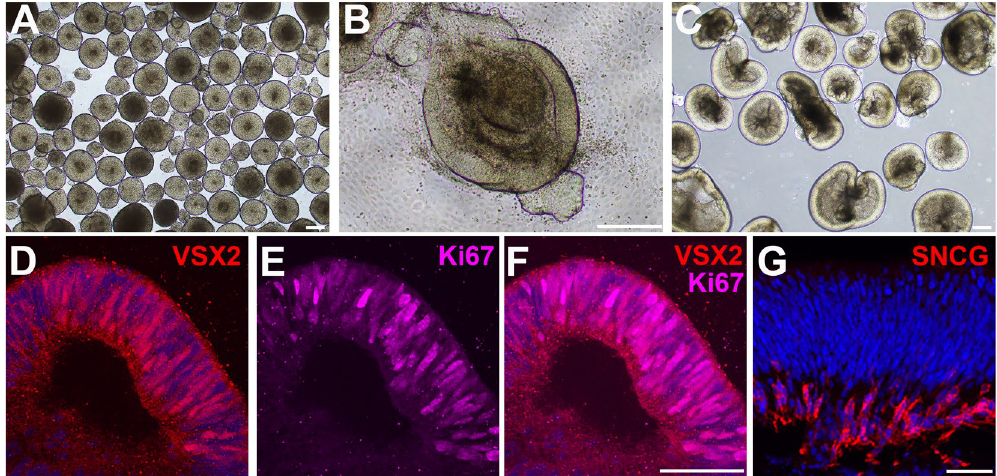
Figure 2. Generation of optic vesicles (OVs) from NRL + /eGFP hESCs. ( A ) Free-floating embryoid bodies (EBs) are shown at day (d) 6. ( B ) EBs are plated, whereupon they form OV-like structures (d26 shown). ( C ) After dissection, OVs are maintained long-term in suspension cultures (d30 shown). ( D–G ) At d30, NRL + /eGFP OVs consist mainly of an outer layer of VSX2 + ( D ) and Ki67 + ( E ) proliferative retinal progenitor cells (merged image in ( F ), and an inner layer of SNCG + retinal ganglion cells ( G ). Scale bars in A–C = 100 µ m; F, G = 50 µ